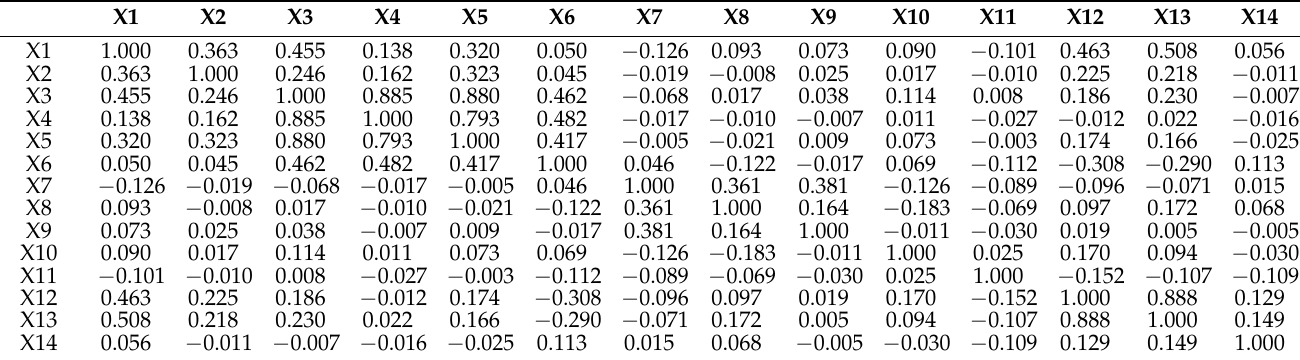
Figure 1. Heat map of the correlation of characteristic variables of rockburst. Table 2. C orrelation coefficient of characteristic variables of rockburst.